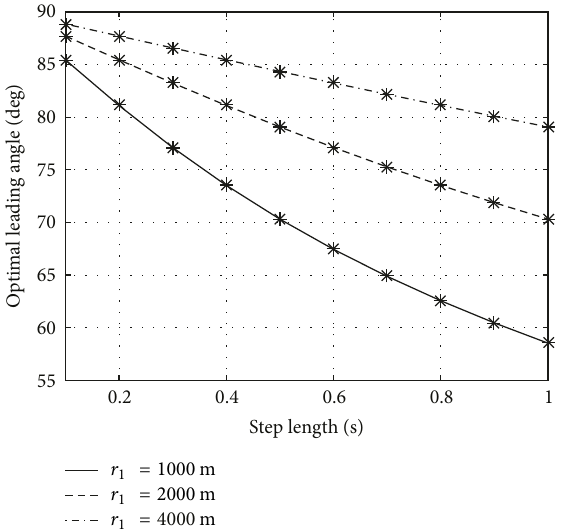
Figure 3: Optimal leading angle with respect to step